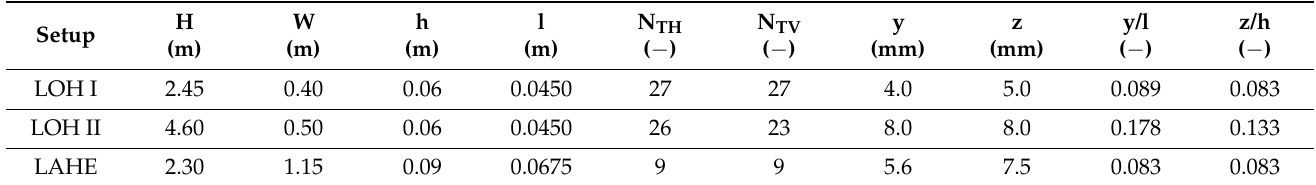
Figure 2. Experimental facilities with spillway models in operation: ( a ) LOH I (q = 0.10 m 2 /s, d c /h = 1.68, Re = 10 5 ); ( b ) LOH II (q = 0.30 m 2 /s, d c /h = 3.49, Re = 3.0 × 10 5 ); ( c ) LAHE (q = 0.36 m 2 /s, d c /h = 2.61, Re = 3.6 × 10 5 ). Table 1. Details of the spillway models and location of the pressure taps on the step